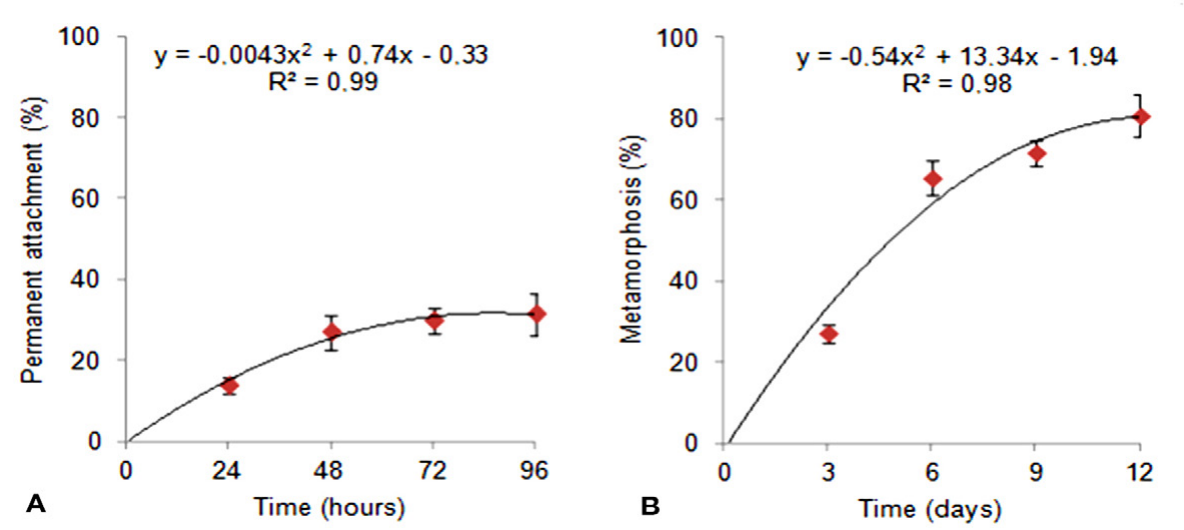
Fig. 4. – Permanent attachment (A -%; mean±SD) and metamorphosis (B -%; mean±SD) of larvae allowed to settle on adults in culture, with time. Permanent attachment was observed at 24-h intervals for a period of 96 h, while metamorphosis was monitored every 3 days for a period of 12 days post-attachment. The fitted curves for permanent attachment (polynomial regression: y=–0.0043x 2 +0.74x–0.33, x ϵ [0,96]; R 2 =0.99, F=133.67, p<0.01) and metamorphosis (polynomial regression: y=–0.54x 2 +13.34x–1.94, x ϵ [0,12]; R 2 =0.98, F=48.76, p=0.02) for the present data are also shown.